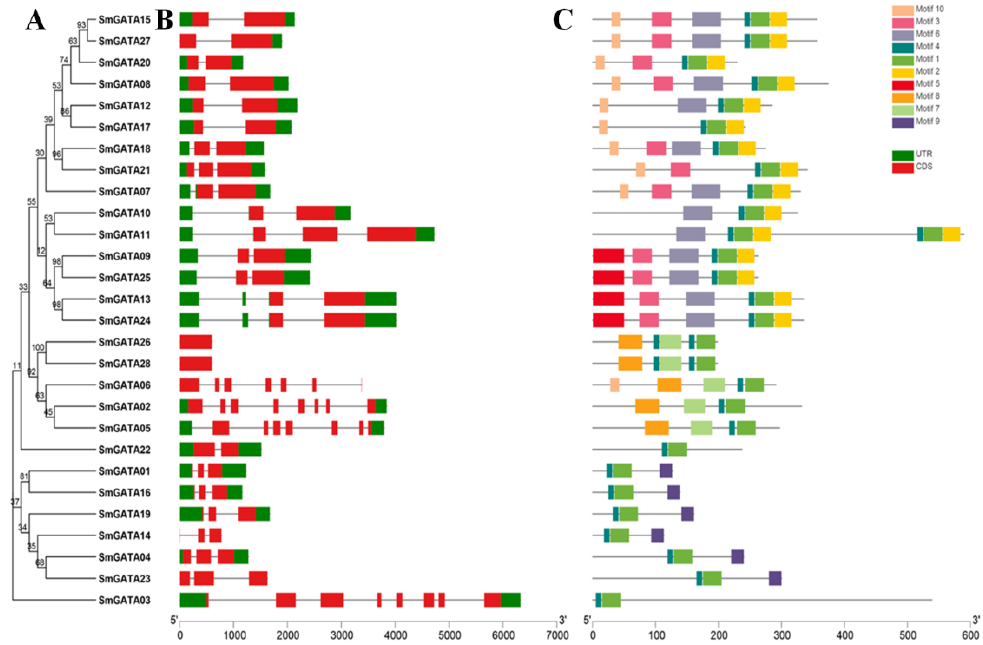
Figure 4. Conserved motifs and structural features of the SmGATA family. ( A ) Phylogenetic tree of SmGATA proteins. ( B ) Gene structures of SmGATA s. The green boxes represent the Untranslated Region (UTR) region of SmGATA genes. Red squares represent CDS and black lines represent introns. ( C ) The conserved motifs of SmGATA proteins. Different motifs are represented by different colored